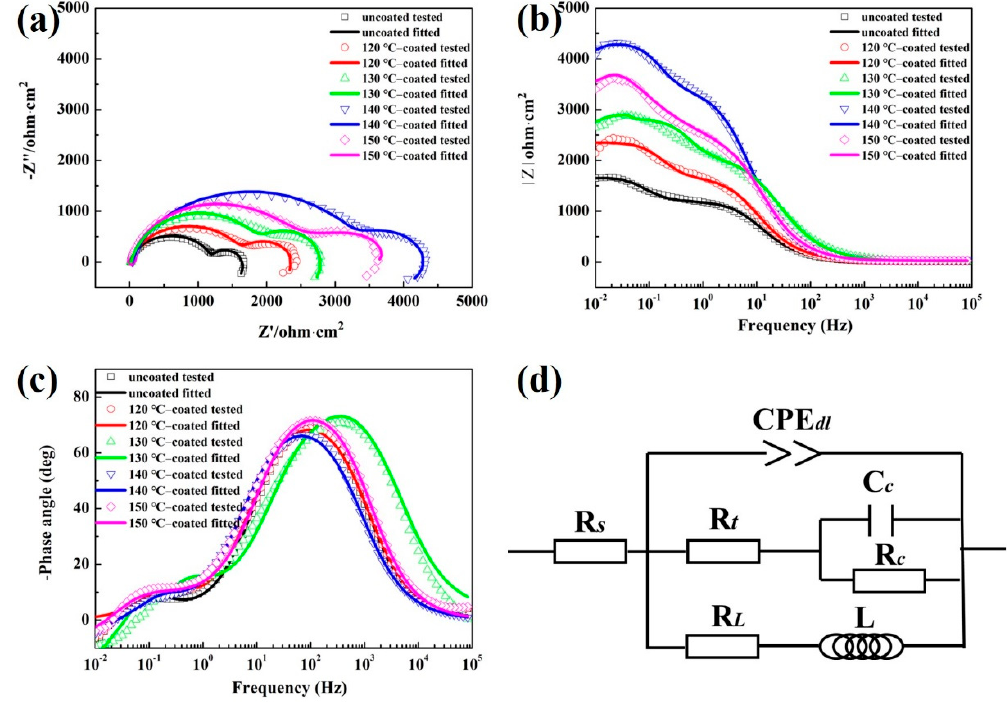
Figure 5. Nyquist ( a ) and Bode ( b , c ) plots for the substrate and coated samples. ( d ) Equivalent electrical circuits.